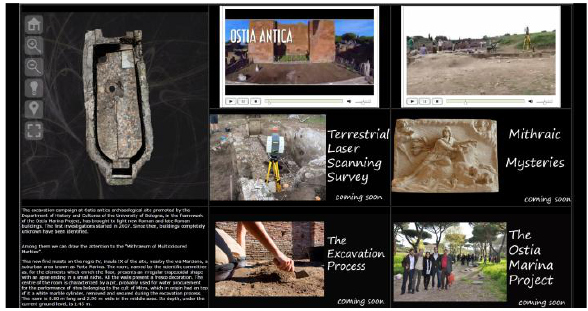
Fig. 8. Traditional Metadata Web